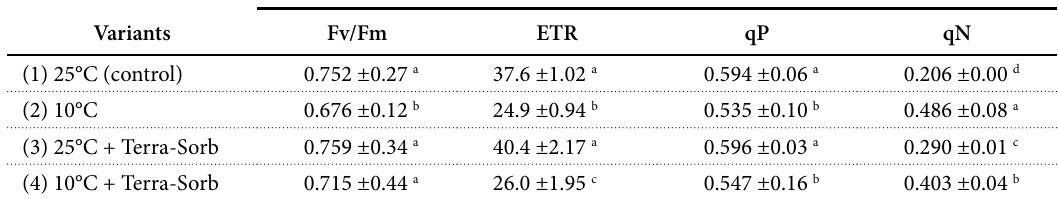
The data presented are sample means ± SD . Different letters (a, b, c, and d) following the SD values indicate significant differences at p <